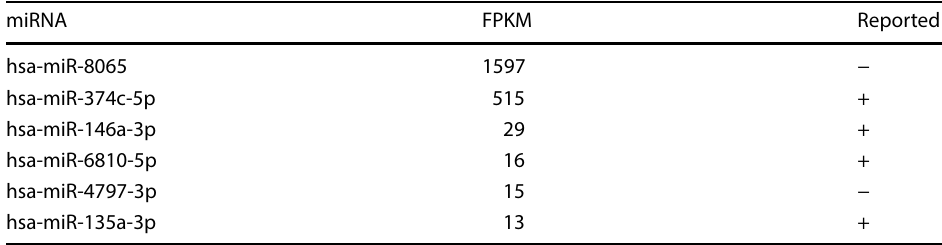
Table 11 Top six treatment- specific miRNA transcripts in OS-R compared to OS cells